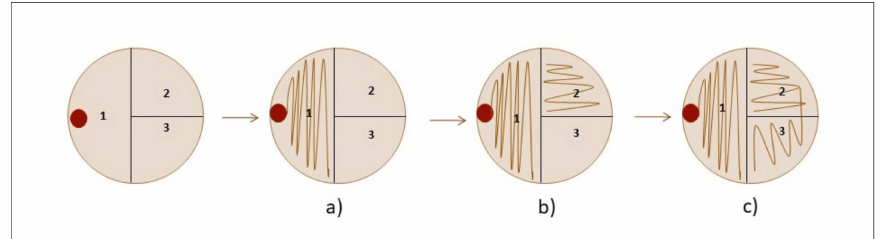
Figure A1. Inoculation technique for InTray cassettes: ( a ) expand the drop by streaking on half the surface (1, first quarter); ( b ) streak on a new quarter (2, second quarter) without touching the previous one; ( c ) repeat on the last quarter (3, third quarter) by touching the previous one.